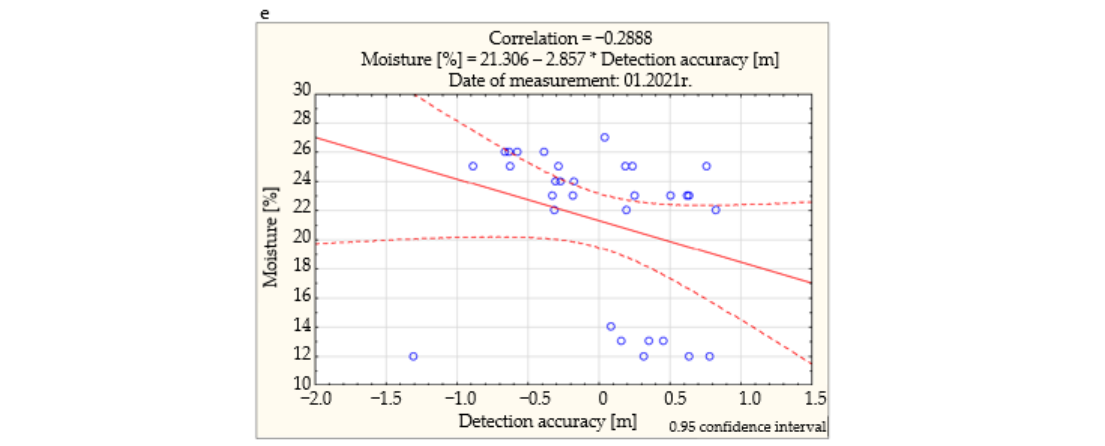
Figure 7. Results of the determination of the Bravais-Pearson coefficient in 5 measurement periods: ( a ) 06.2020, ( b ) 08.2020, ( c ) 09.2020, ( d ) 11.2020, ( e ) 01.2021.